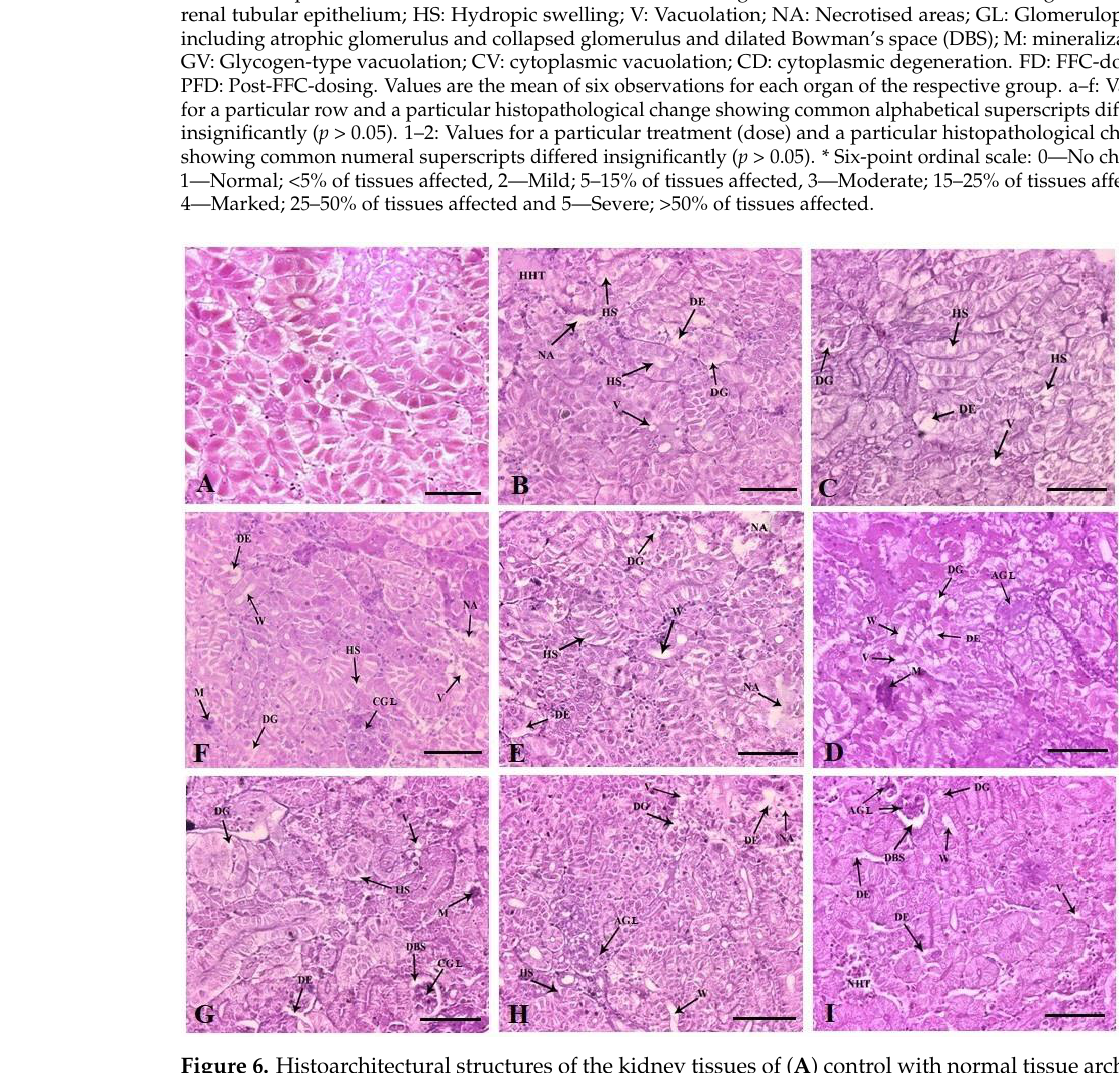
Figure 6. Histoarchitectural structures of the kidney tissues of ( A ) control with normal tissue architec- ture × 200 and dietary florfenicol (FFC)-administered Oreochromis niloticus juveniles for 10 consecutive days on day 10 FFC-dosing at ( B ) 15 mg kg biomass − 1 day − 1 [1 × ], ( C ) 45 mg kg biomass − 1 day − 1 [3 × ], ( D ) 75 mg kg biomass − 1 day − 1 [5 × ] and ( E ) 150 mg kg biomass − 1 day − 1 [10 × ] × 200, and on day 43 post FFC dosing at ( F ) 1 × , ( G ) 3 × , ( H ) 5 × and ( I ) 10 × , × 200 showing degeneration of renal tubules (DG) and tubular epithelium (DE), hydropic swelling (HS), necrotized areas (NA), external vacuolation (V), hypoplastic haematopoietic tissues (HHT), mineralization (M), widening of the lumen (W), atrophic glomerulus (AGL), collapsed glomerulus (CGL), necrotised haematopoietic tissues (NHT) and dilated Bowman’s space (DBS). H&E staining, Scale Bars ( A – I ): 25 µ m. Histologically, the liver of the control fish was characterized by normal parenchyma and regular hepatocytes (Figure 7A). The 1× group had glycogen-type vacuolation (se- vere), cytoplasmic vacuolation (mild), cytoplasmic degeneration and necrotized areas on day 10 of FD. The hepatocyte nuclei were generally aggregated towards the hepatic cords (Figure 7B). Similar changes were observed in an increased fashion, correlating with dose increment (Figures 7C – E). Nuclear disorders, such as binucleated hepatocytes and degen- erative hepatocytes, were profoundly visible in all the dosing groups. In the therapeutic group, the recovery of the liver tissue architecture was demonstrated on the last day of experimentation. The glycogen-type vacuolation was significantly reduced in the 1× group (Figure 7F). The 3× – 10× groups disclosed no recoveries with the persistence of nu- clear anomalies (Figures 7G – I and Table 2).